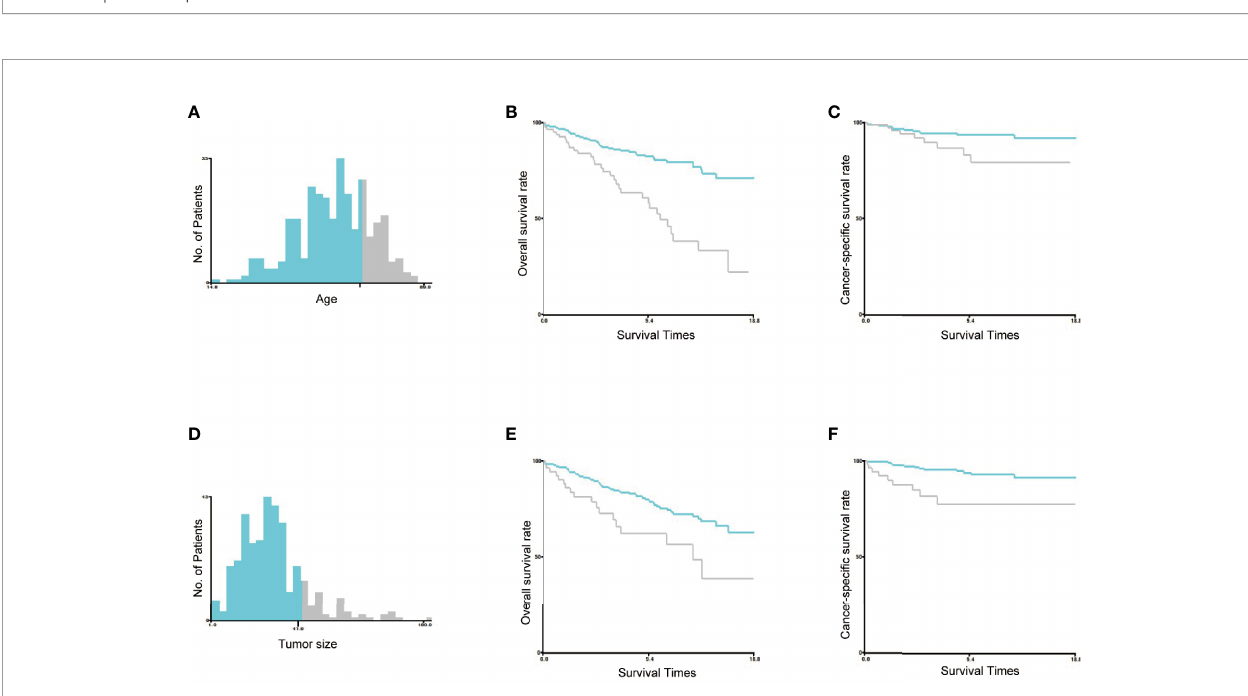
FIGURE 1 | The data process fl owchart.